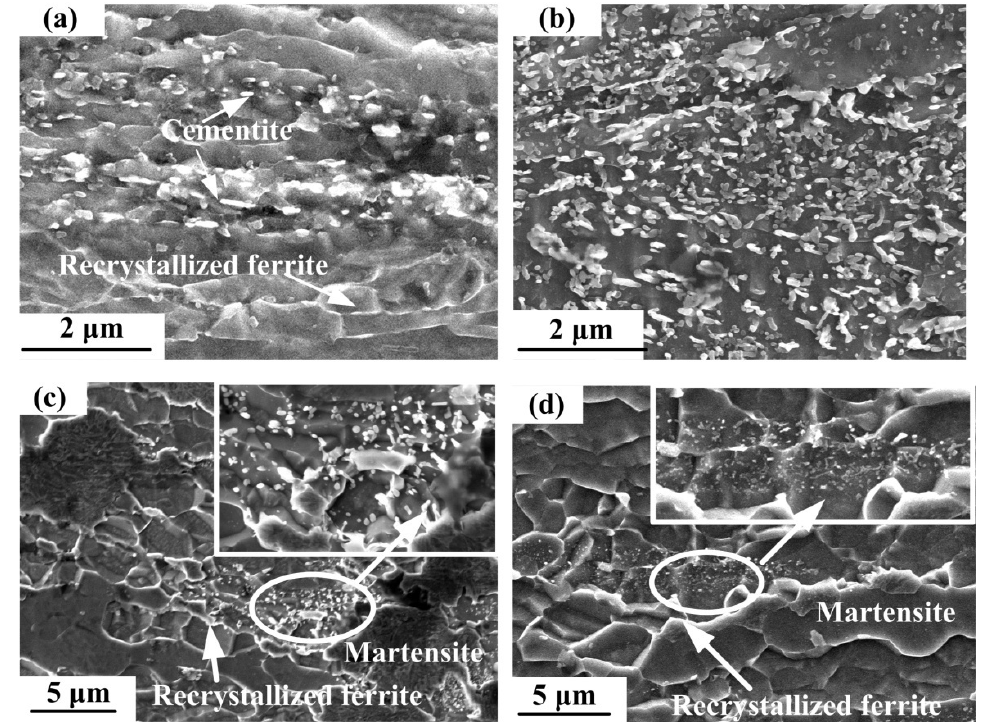
Figure 4. High magnification SEM images of ( a ) 650 °C, 0.1 s −1 ; ( b ) 700 °C, 10 s −1 ; ( c ) 750 °C, 0.1 s −1 ; ( d ) 750 °C, 10 s −1 .